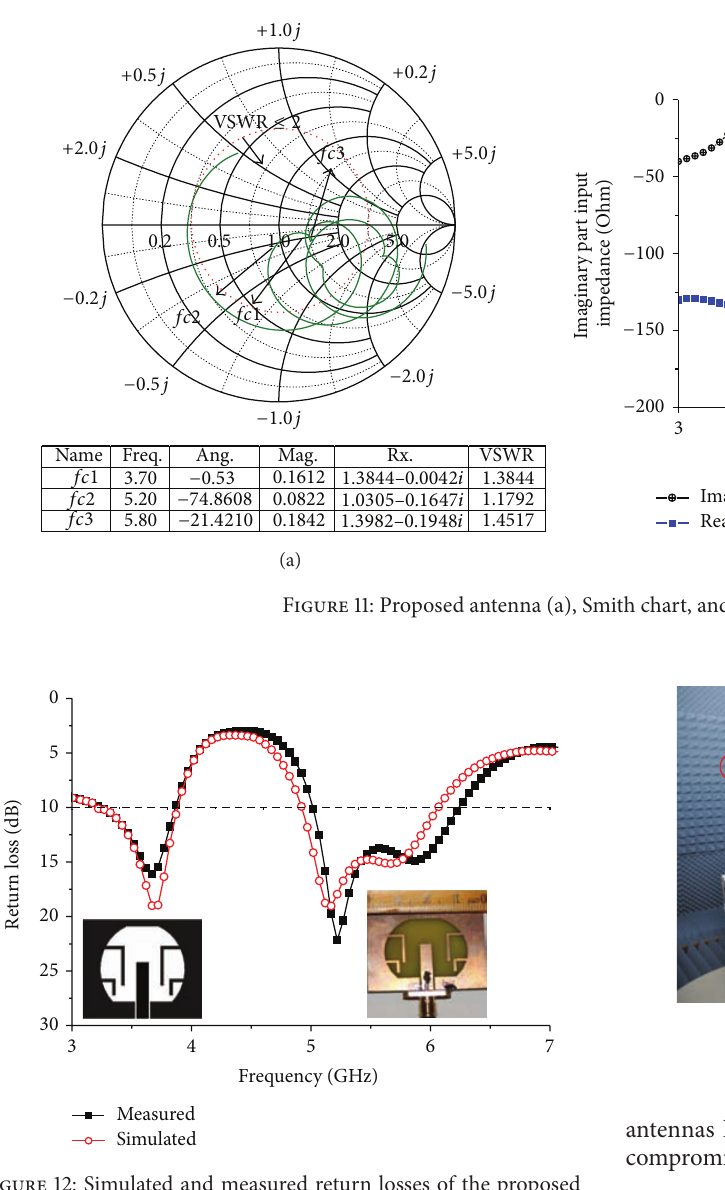
Figure 12: Simulated and measured return losses of the proposed antenna.